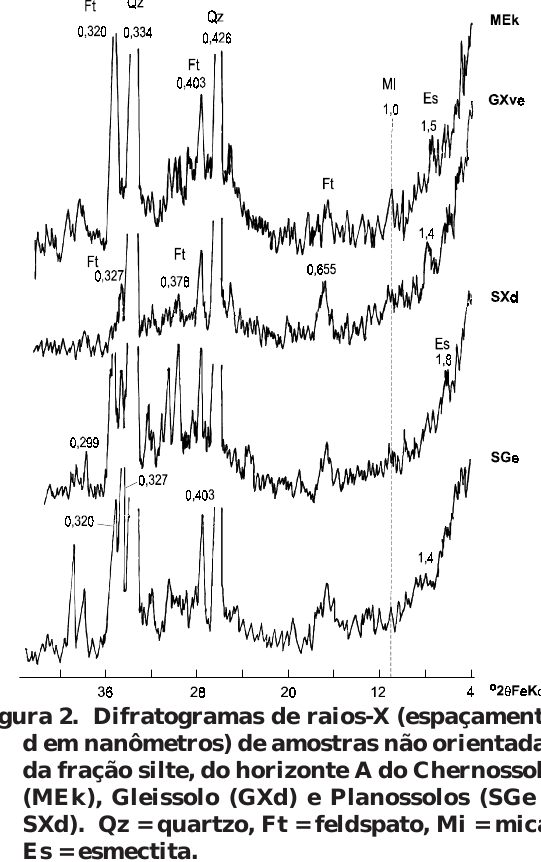
Figura 1. Difratogramas de raios-X (espaçamento d em nanômetros) de amostras não orientadas da fração areia, do horizonte A do Chernossolo (MEk), Gleissolo (GXve) e Planossolos (SGe e SXd). Qz = quartzo, Ft = feldspato, Mi = mica.